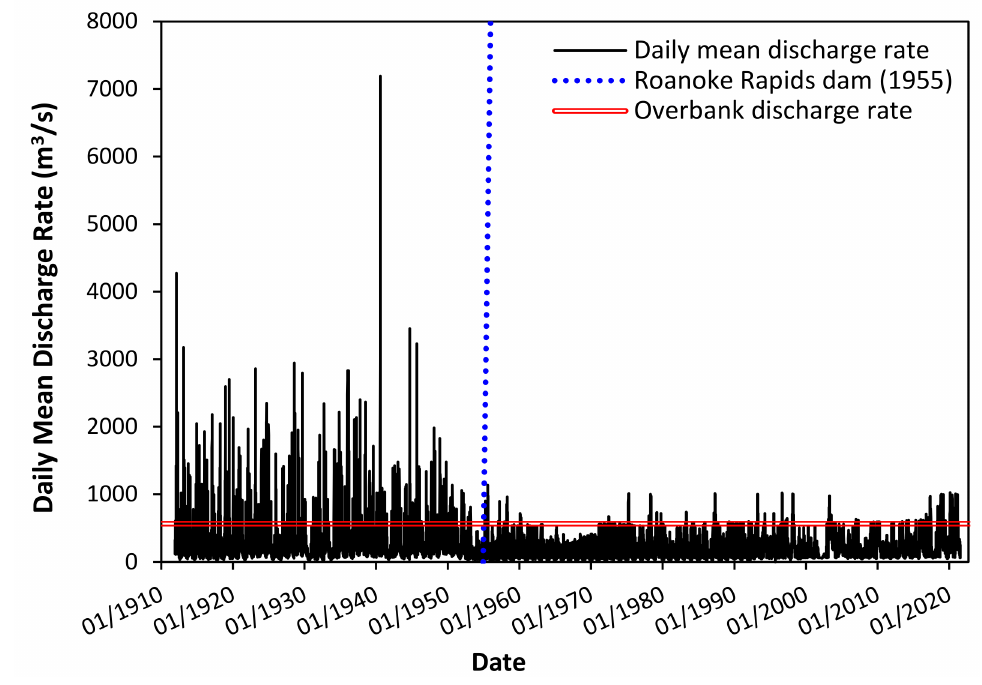
Figure 2. Hydrograph before and after the construction of Roanoke Rapids Dam,